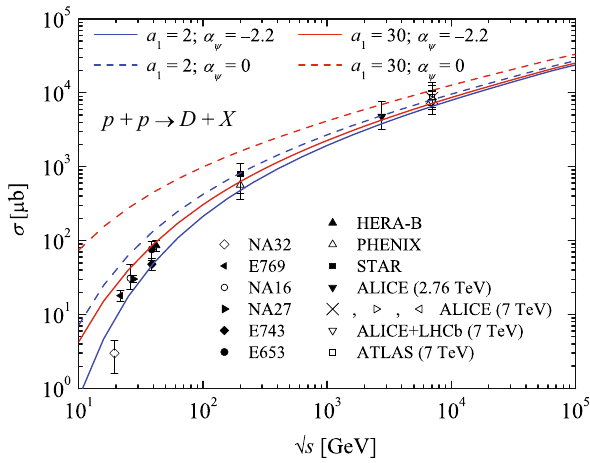
Fig. 1 Totalcrosssectionsof D / ¯ D mesonsproductionin pp collisions. QGSM calculations: α ψ ( 0 ) = − 2 . 2 (solid lines), α ψ ( 0 ) = 0 (dashed lines); blue (bottom): a 1 = 2; red: a 1 = 30. The experimental data are taken from Refs. [16–19,37–45]